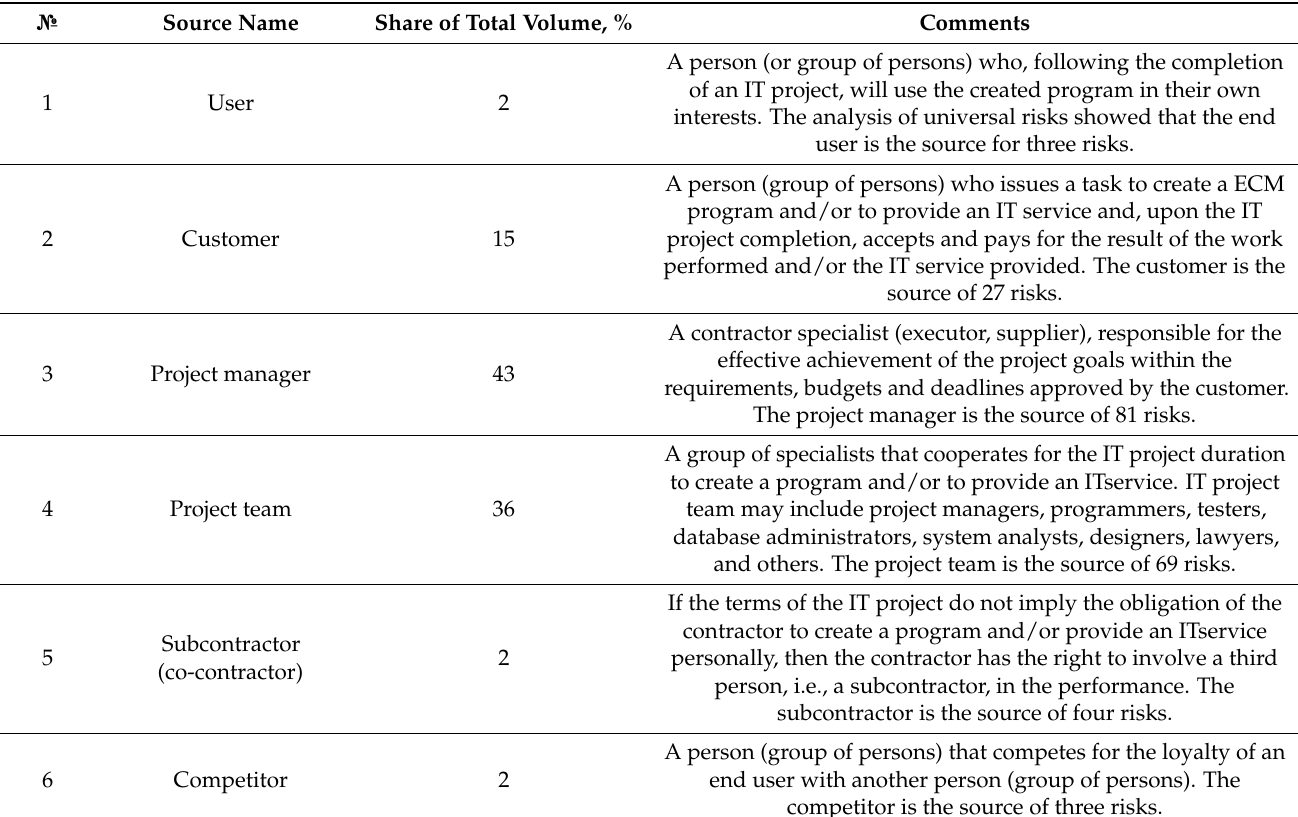
Table 4. Sources of IT project